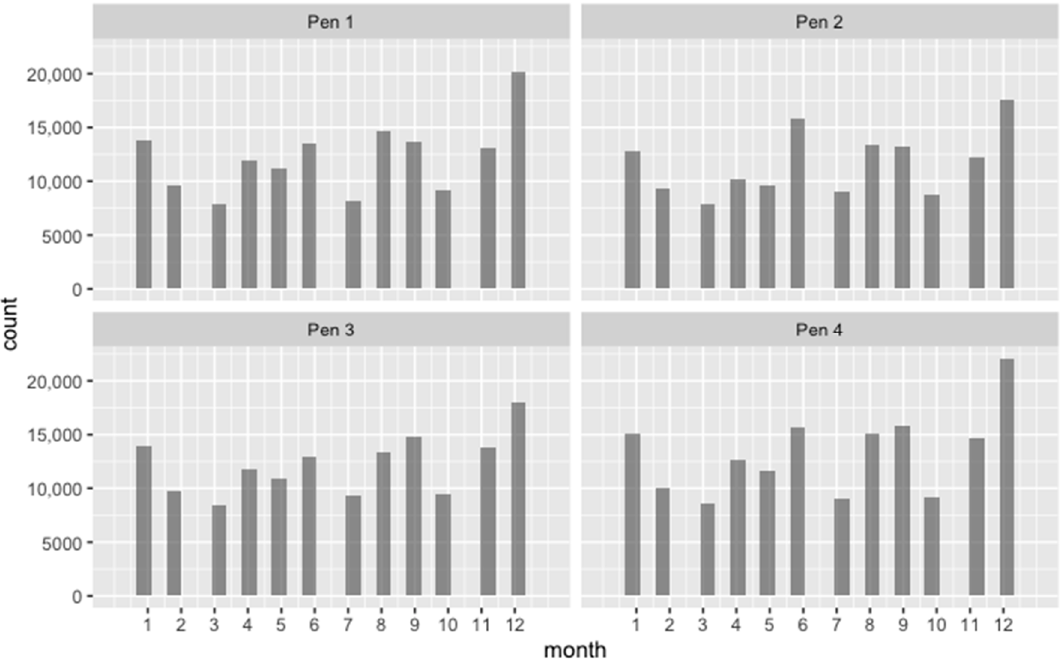
Figure A1. Count of the gate passage per month by pen.